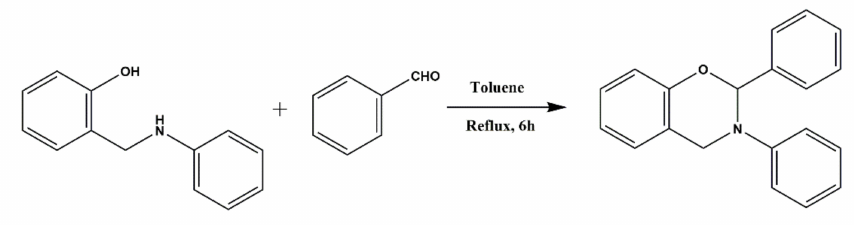
Scheme 2. Preparation of PH-a-[ 2 ] ba from h PH-a and